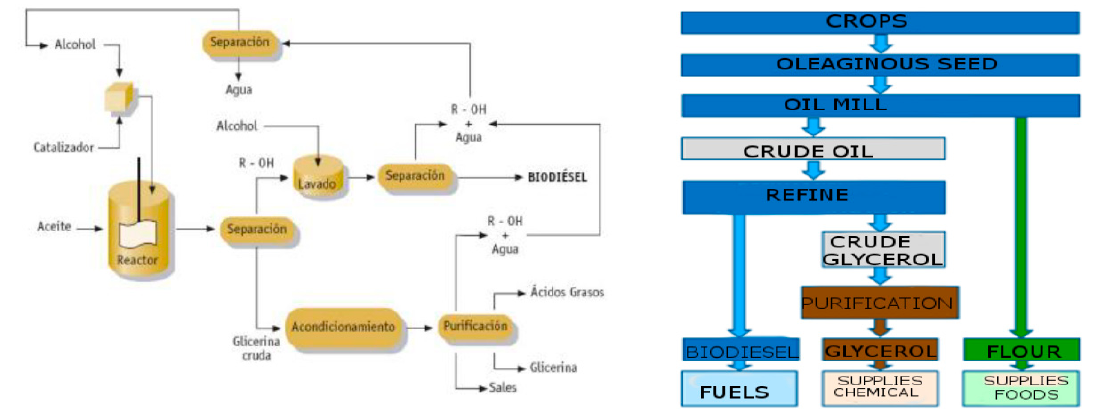
Figure 2. Biodiesel production based on